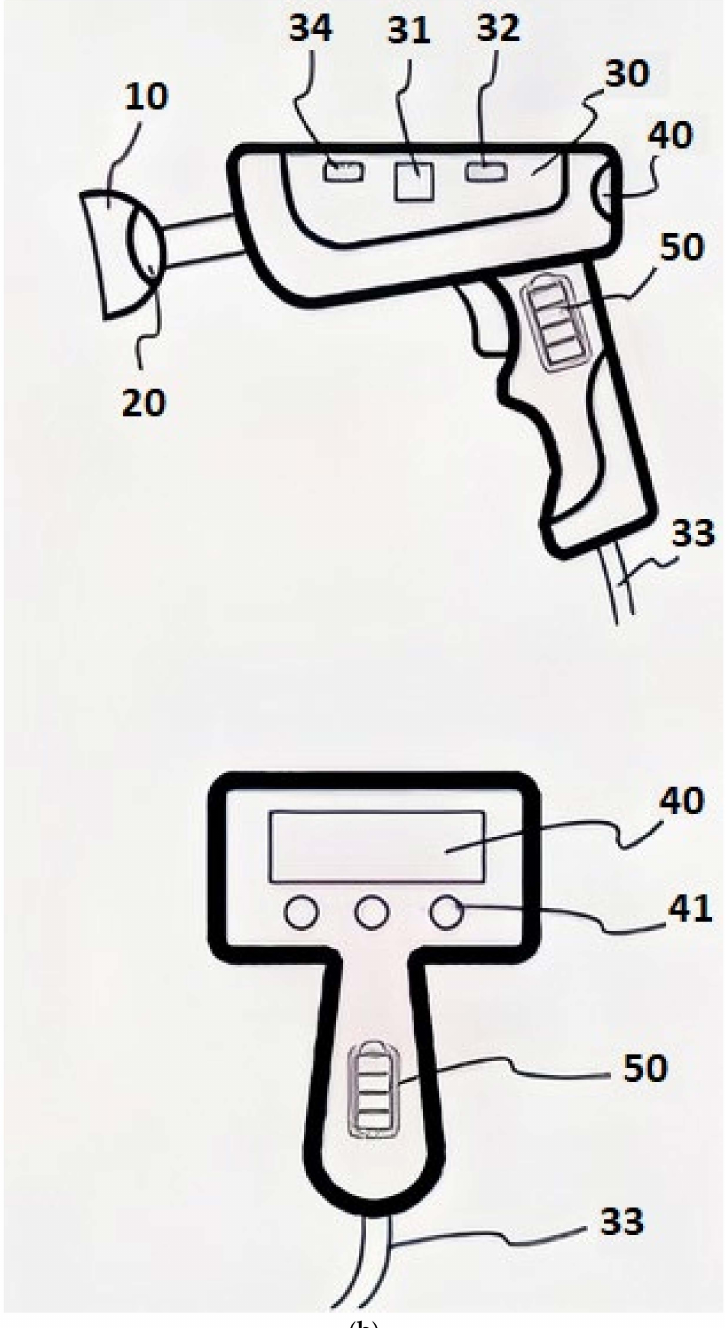
Figure 1. ( a ) DEvice© ocular hygrometer. ( b ) A schematic design of the diagnostic tool